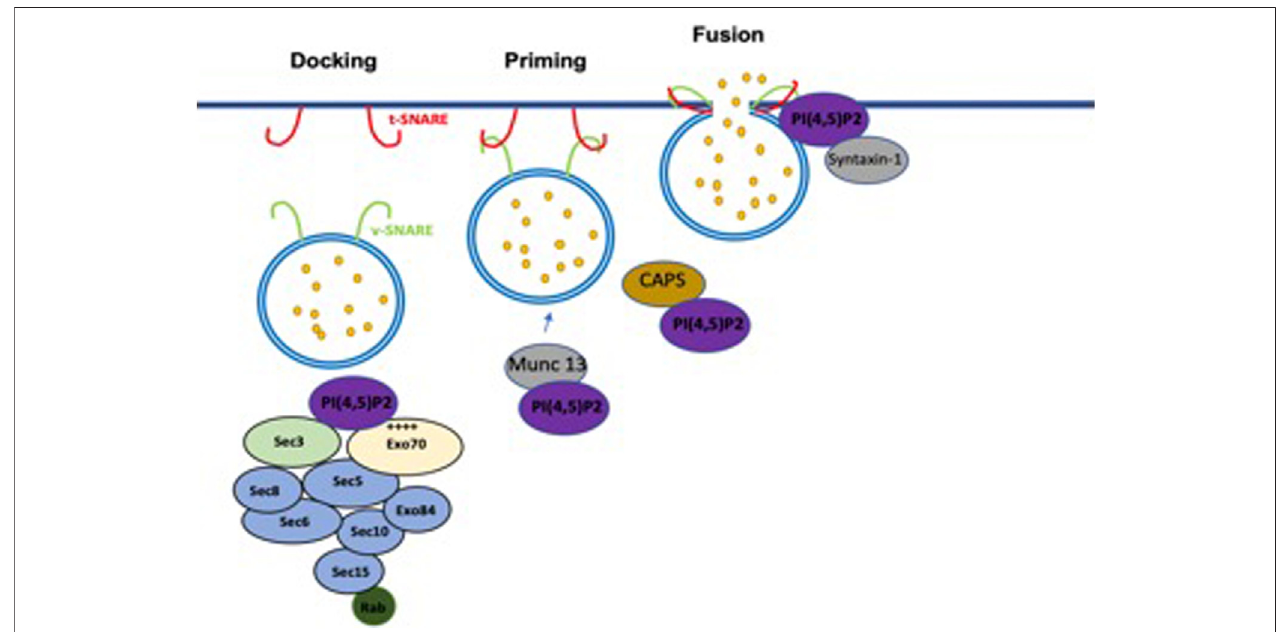
FIGURE 2 | Involvement of PI(4,5)P2 in the exocytosis steps. PI(4,5)P2 is required for mediating tethering of vesicles to the PM. In the priming step, PI(4,5)P2 modulates the vesicles priming by interacting with Munc13 and CAPS. PI(4,5)P2 controls vesicles fusion by interacting with SNARE complex.